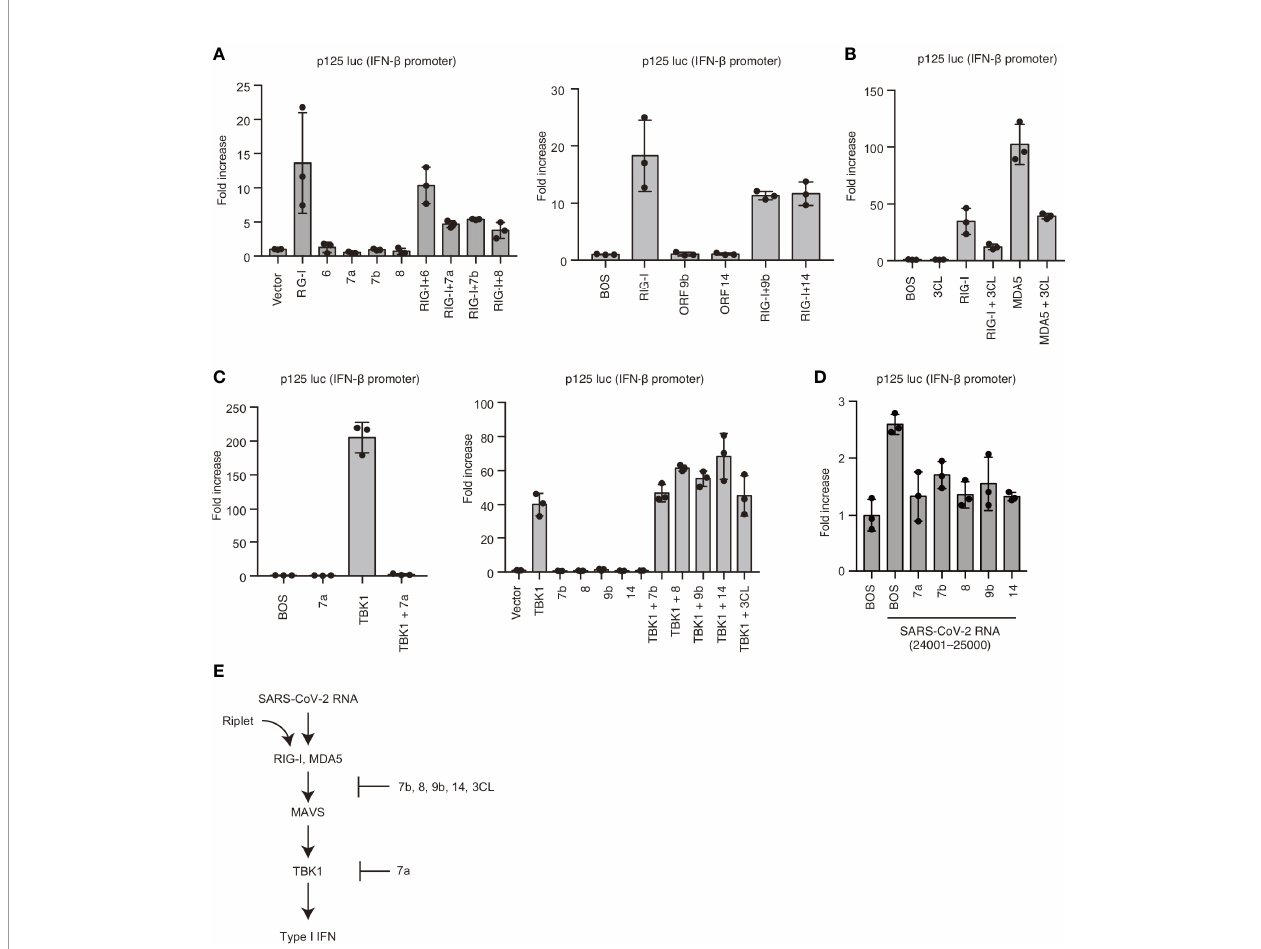
FIGURE 5 | Viral proteins attenuated RIG-I-mediated signaling. (A) RIG-I, viral ORF 6, 7a, 7b, 8, 9b, and 14 expressing vectors were transfected into HEK293 cells with p125 luc plasmid for 24 h, and the luciferase activities were determined. The data represent the mean ± SD (n = 3). The data shown is representative of three independent experiments. (B) RIG-I, MDA5, and viral 3CL protein expressing vectors were transfected into HEK293 cells together with p125 luc plasmid for 24h, and the luciferase activities were determined. The data represent the mean ± SD (n = 3). The data shown is representative of three independent experiments. (C) TBK1, viral ORF 7a, 7b, 8, 9b, 14, and 3CL expressing vectors were transfected into HEK293 cells together with p125 luc plasmid for 24 h, and the luciferase activities were determined. The data represent the mean ± SD (n = 3). The data shown is representative of three independent experiments. (D) HEK293 cells were transfected with viral ORF 7a, 7b, 8, 9b, or 14 expressing vectors together with p125luc plasmid. Twenty-four hours after transfection, cells were then stimulated with the viral fragment trasnfection containing 24001 – 25000, then luciferase activities were determined. The data represent the mean ± SD (n = 3). The data shown is representative of three independent experiments. (E) Schematic representation of the cytoplasmic type I IFN expression pathway and viral protein-mediated suppression.